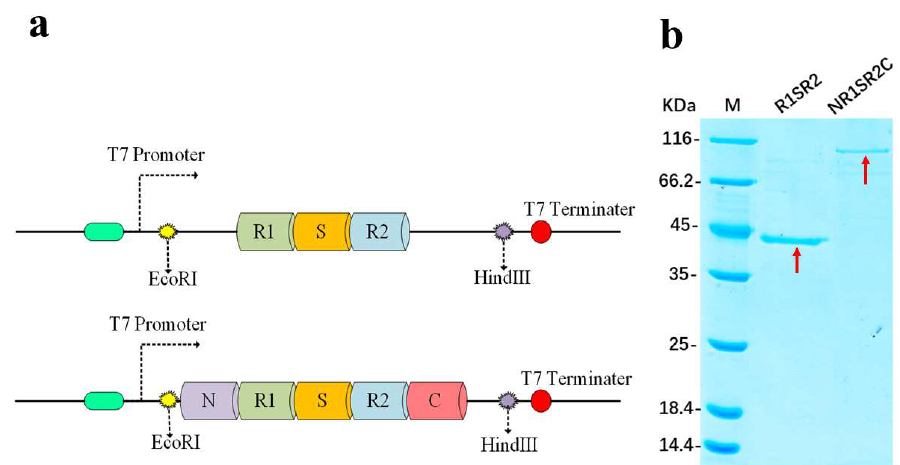
Figure 1. Production and purity of recombinant silk proteins. ( a ) Constructs. ( b ) SDS-PAGE results. The red arrows are bands of the target proteins.